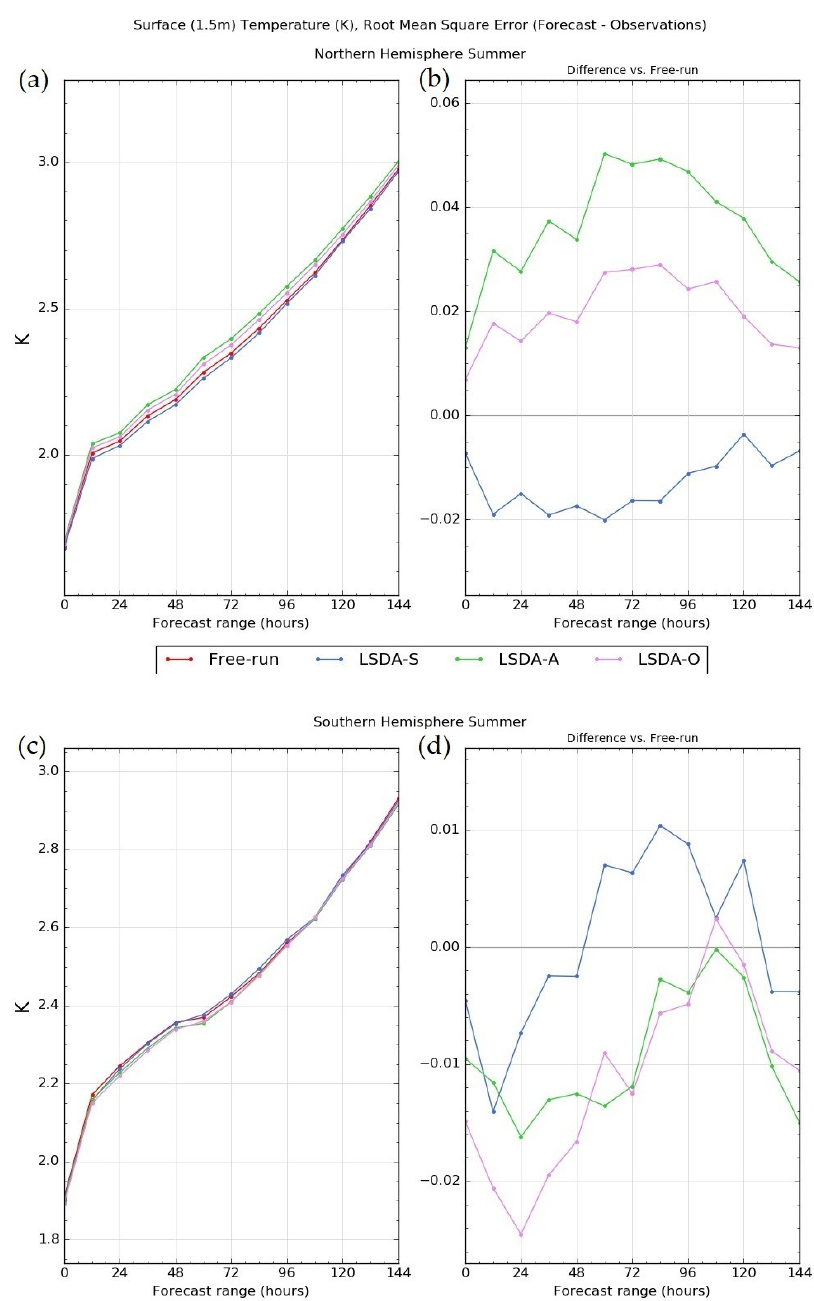
Figure 3. As in Figure 2, but for the summer period of 1 July, 2017 to 30 September, 2017 (92 days) for the Northern hemisphere (panels a , b ) and 1 December, 2017 to 19 February, 2018 (81 days) for the Southern hemisphere (panels c , d ).